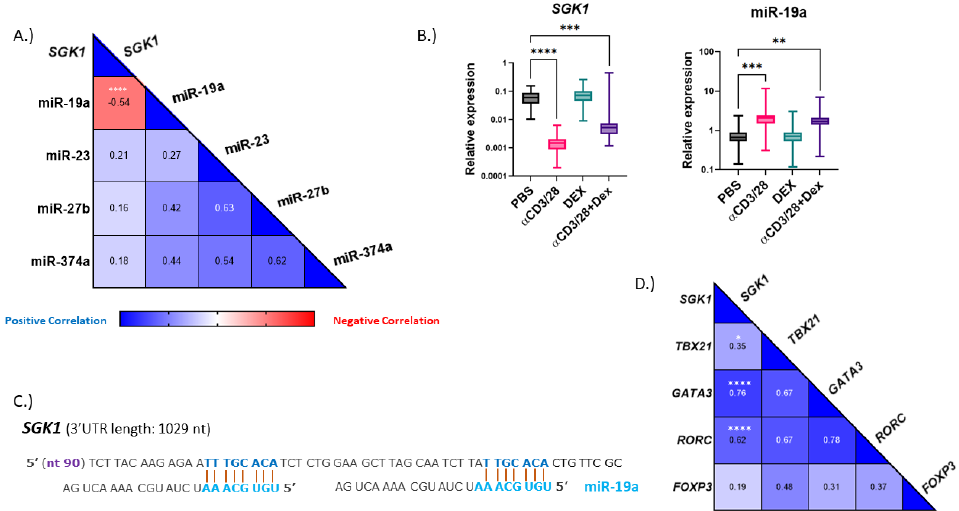
Figure 2. SGK1 is predicted to be bound by miR-19a and correlates to T cell transcription factors. PBMCs were isolated from whole blood and treated for 48 h with α CD3 α CD28 ( α CD3/28), dexamethasone (DEX), α CD3 α CD28 and dexamethasone ( α CD3/28 + DEX) or medium alone (PBS), before RNA was isolated. ( A ) Bioinformatic analysis identified several miRNAs that may target SGK1 ; using pooled data from both healthy and asthmatic individuals, miR-19a was found to have a strong negative correlation. ( B ) Relative expression of SGK1 and miR-19a from total PBMCs with the re- spective treatment. Relative expression shown as 2 − dCT . n = 20/condition. ( C ) Predicted binding sites in the SGK1 3′ UTR for miR-19a. Blue indicates the seed sequence. ( D ) Transcription factors TBX21 , GATA3 , RORC and FOXP3 were examined in the same PBMCs to examine correlations to SGK1 . * = p < 0.05; ** = p <0.01; *** = p < 0.001; **** = p < 0.0001.